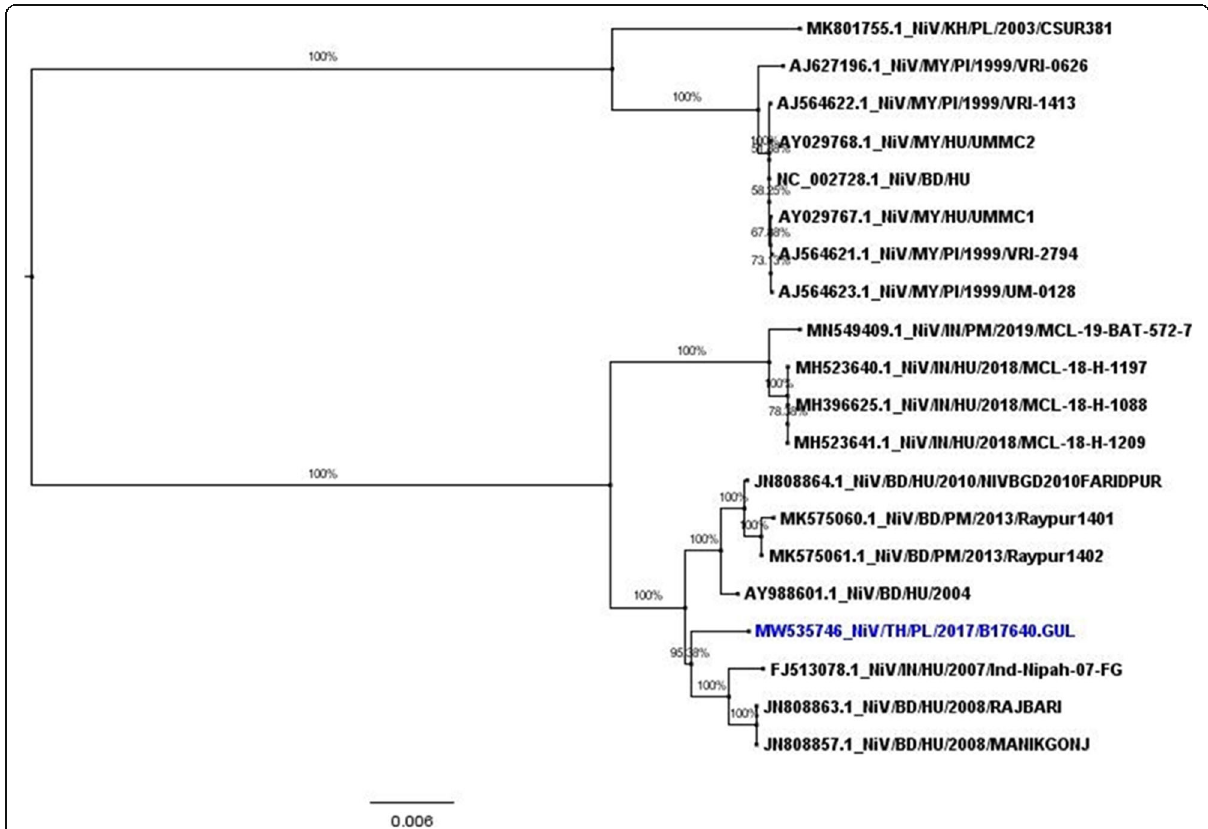
Fig. 3 Phylogenetic tree analysis of NiV whole genome sequence (18,127 nucleotides each) isolated from P. lylei in Thailand in 2007 (shown in blue). Maximum-likelihood method was used to analyze phylogenetics, using sequences from pigs, bats, and humans available in GenBank (shown in black). HU = Human; PI = Pig; PL = P. lylei ; PM = P. medius; MY = Malaysia; BD = Bangladesh; IN = India; KH = Cambodia; TH = Thailand